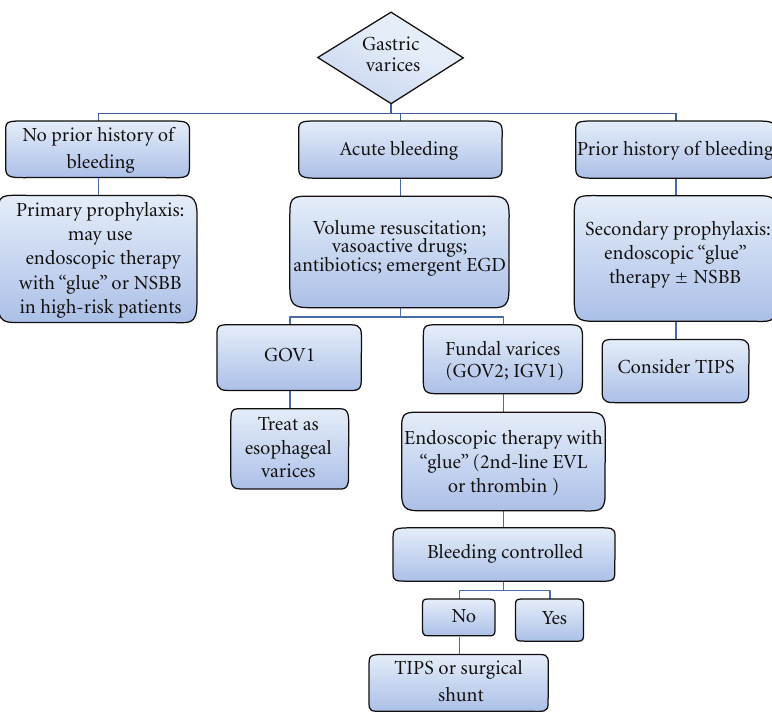
Figure 4: Algorithm for endoscopic management of gastric varices. NSBB indicates nonselective beta blockers; EGD: esophagogastro- duodenal endoscopy; GOV: gastroesophageal varices; IGV: isolated gastric varices; EVL: endoscopic variceal ligation; TIPS: transjugular intrahepatic portosystemic